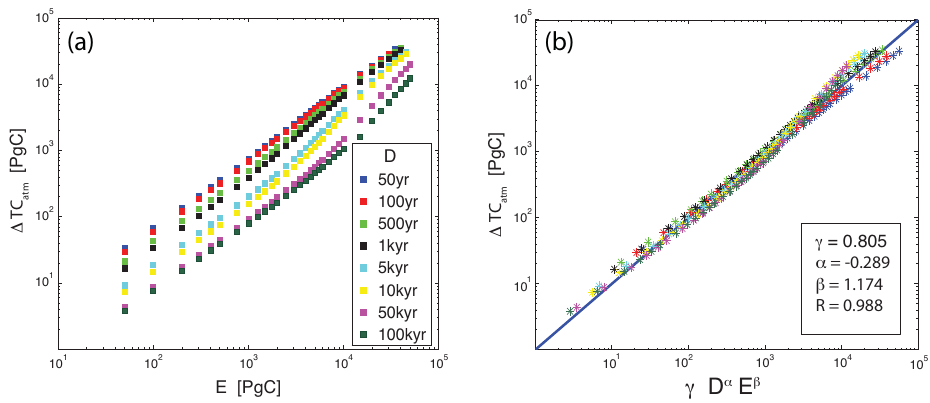
Figure 8. (a) Peak changes in the modern atmospheric total carbon content as a function of total emission, E , for various durations, D . (b) Multivariable regression results. Solid line indicates a perfect fit to the predicted scaling. The asterisks are each individual cases.